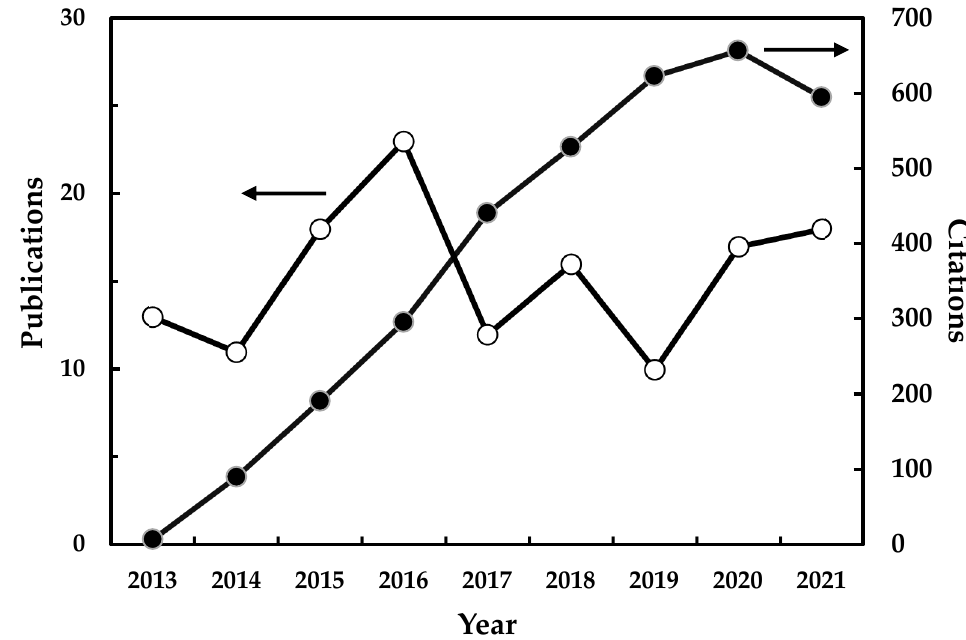
Figure 1. Number of publications ( ‐ ○ ‐ ) and citations ( ‐ • ‐ ) of procedures with metal ions biosensing since 2013. Data were retrieved from ISI Web of Knowledge.